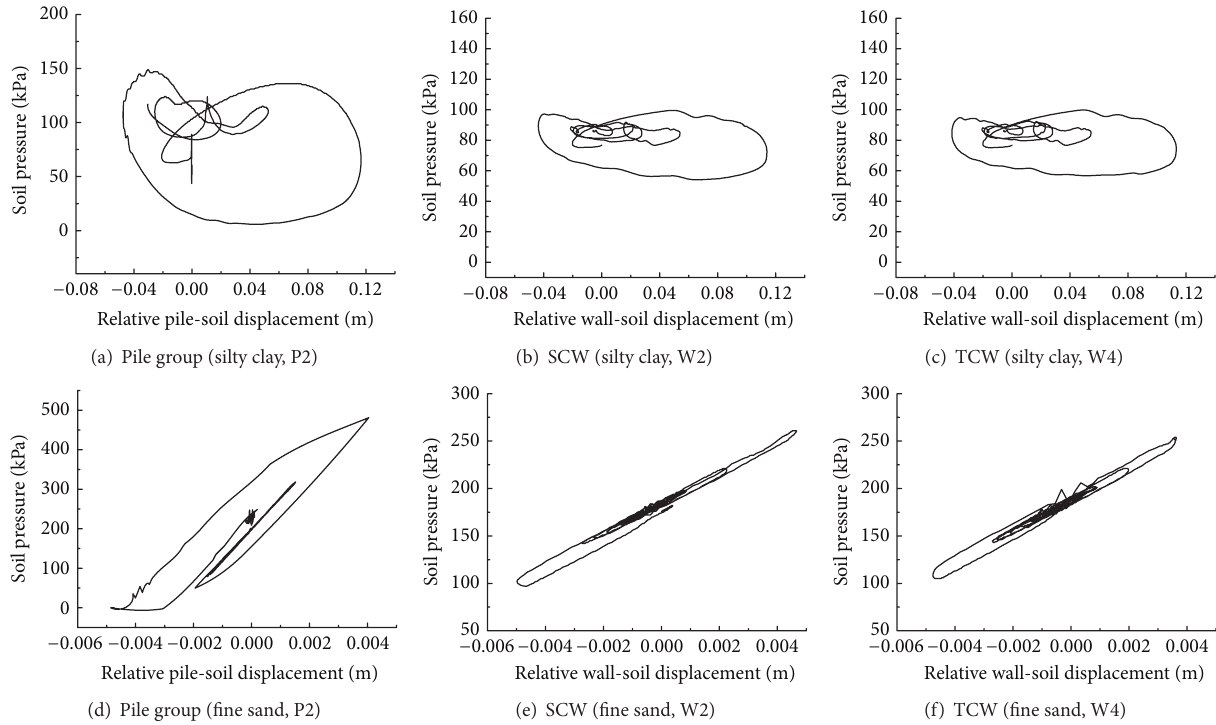
Figure 20: Dynamic p-y curves of three models in different soil